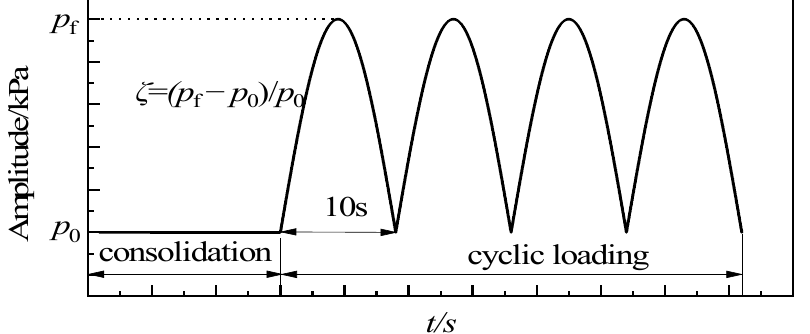
Figure 2. Loading and waveform diagram.